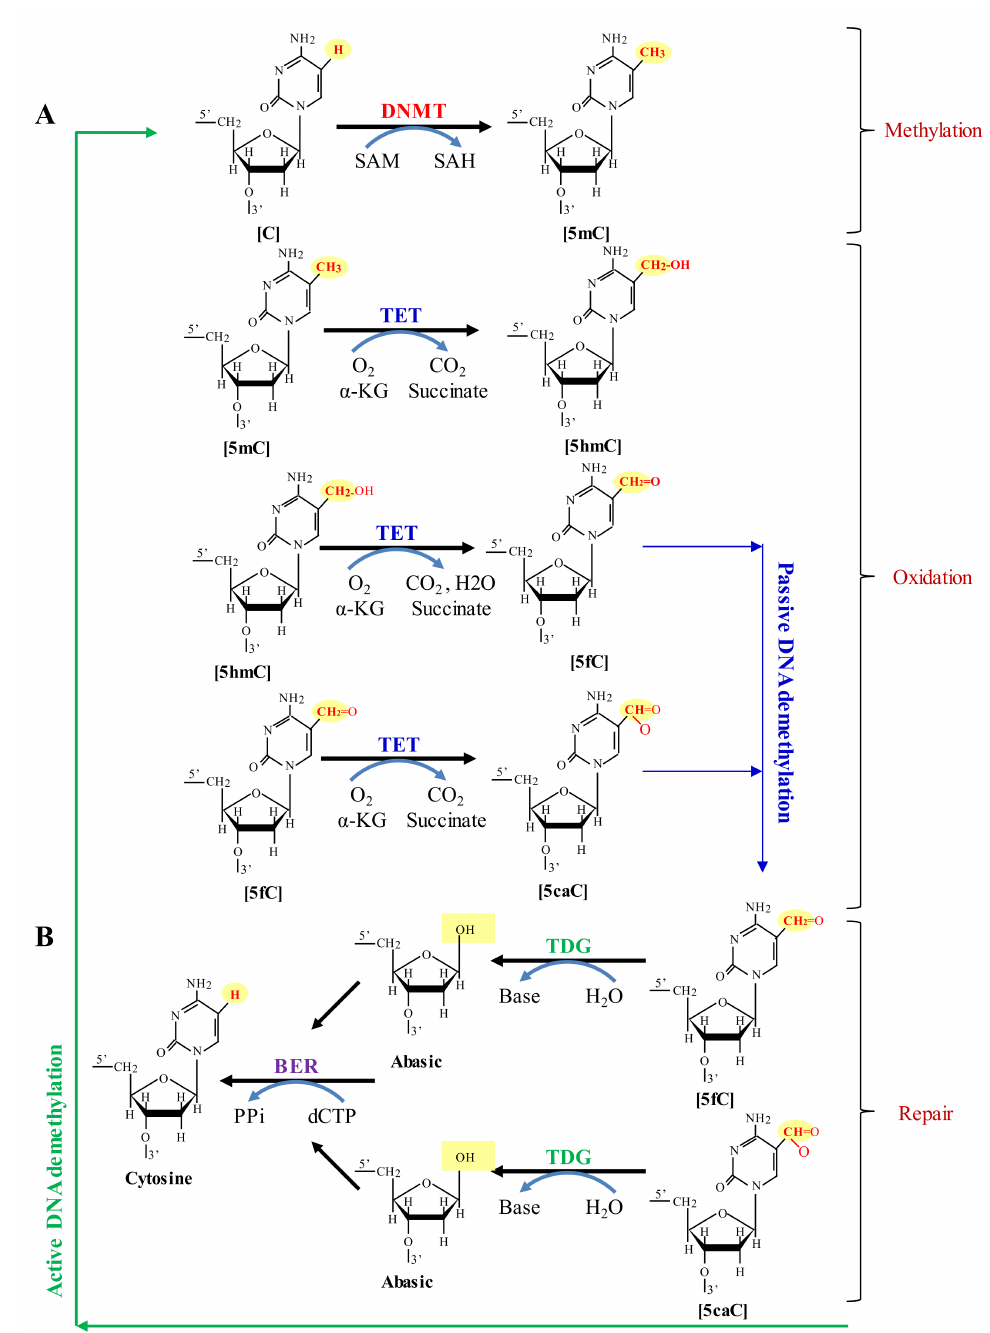
Figure 3. Steps for dynamic modifications of Cytosine and TET-mediated oxidation. ( A ) The methy- lation of deoxycytosine (C) residues to 5-methylcytosine (5mC) are introduced by DNA methyl- transferase (DNMT) enzymes and sequentially oxidized by ten–eleven translocation (TET) enzymes via 5-hydroxymethylcytosine (5mC), 5-formylcytosine (5fC) and 5-carboxylcytosine (5caC). SAM, S-adenosylmethionine; SAH, S-adenosylhomocysteine; α -KG, α -ketoglutarate. ( B ) 5fC and 5caC are identified and excised by thymine DNA glycosylase (TDG) to produce an abasic site. The base-excision-repair (BER) pathway implicates excision of the abasic site, replacement of the nu- cleotide using unmodified deoxycytidine triphosphate (dCTP) by a DNA polymerase (generating pyrophosphate, PPi) and ligation to repair the nick. Different TET gene isoforms are expressed in various cells and organs. In the TET dioxygenase family, a minimum of two TET1, one TET2 and three TET3 isoforms has